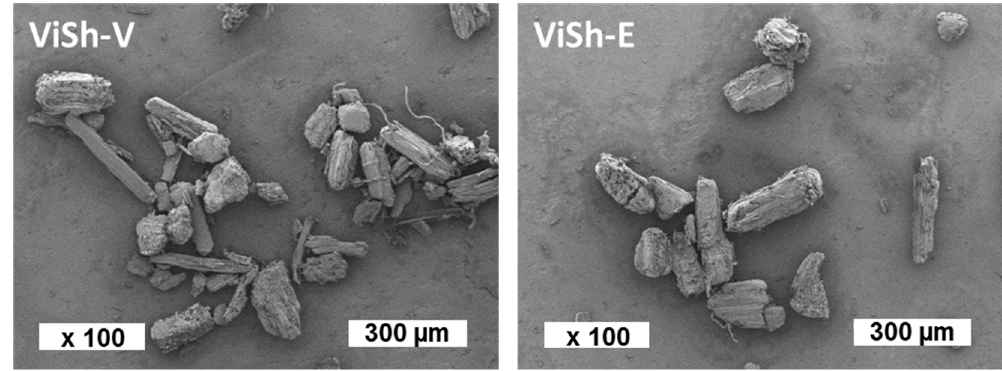
Figure 1. Scanning electron microscopy (SEM) pictures of vine shoots fillers.